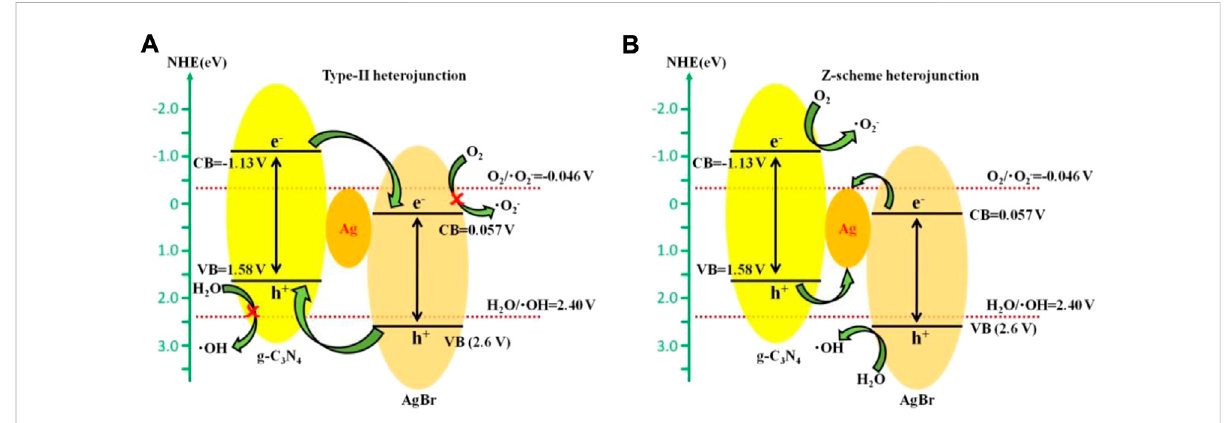
FIGURE 8 Photocatalytic mechanism of g-C 3 N 4 /Ag/AgBr based on (A) type-II heterojunction (A) and Z-type heterojunction (B)